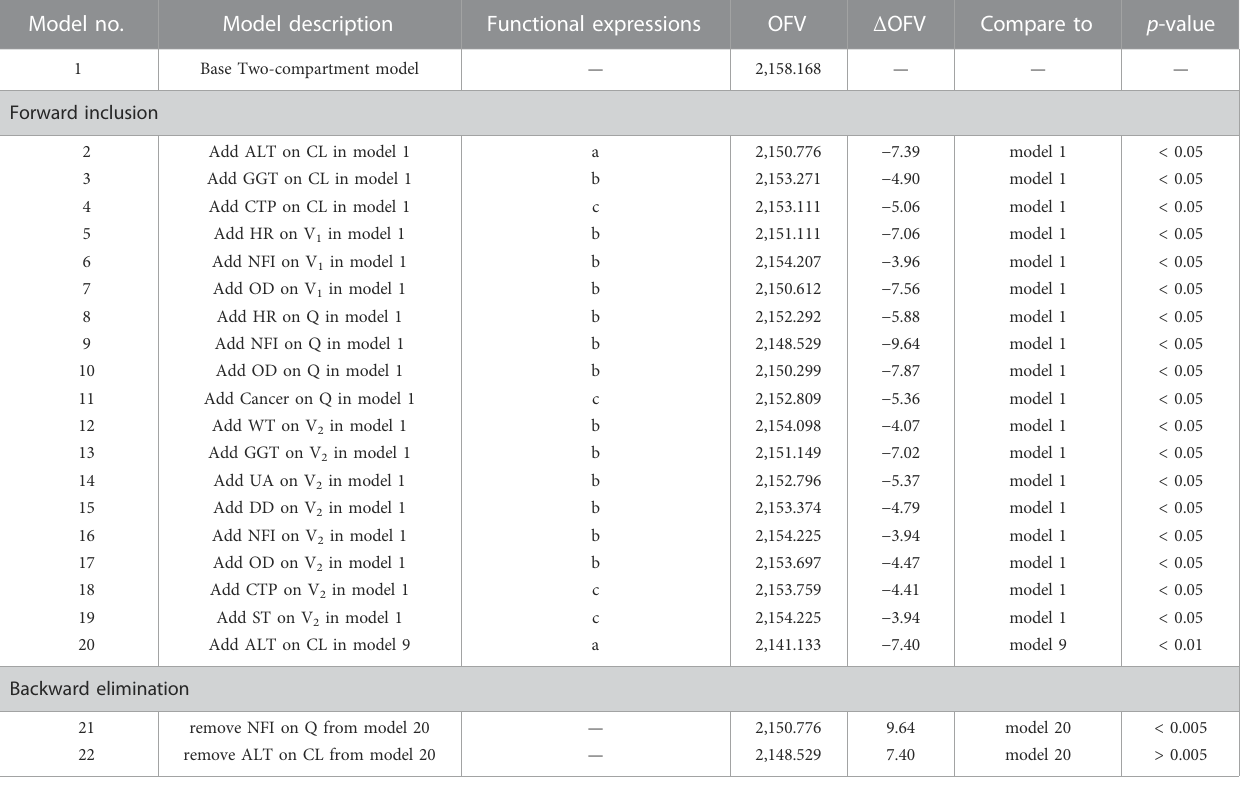
TABLE 3 The stepwise process of building the PopPK model of nalbuphine. Model no.